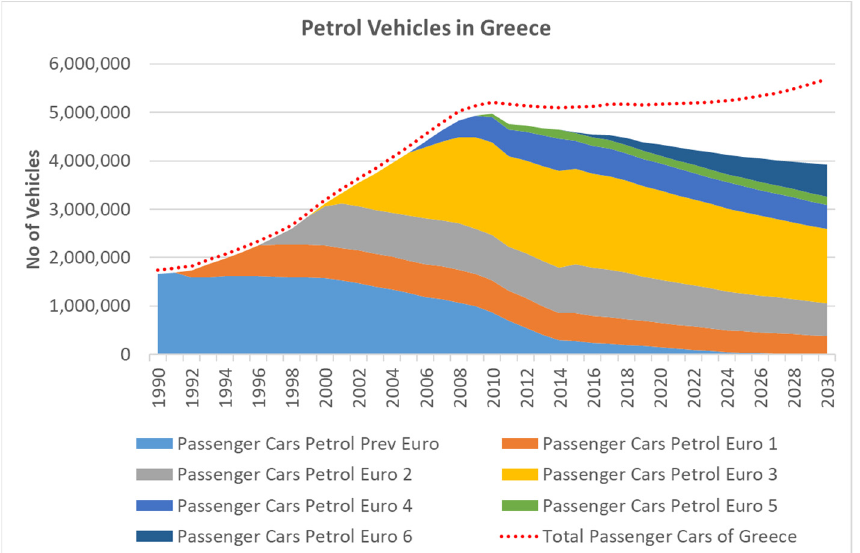
Figure 5. Time-evolution of the fleet size of petrol-powered vehicles and total passenger vehicles in Greece, 1990–2030.